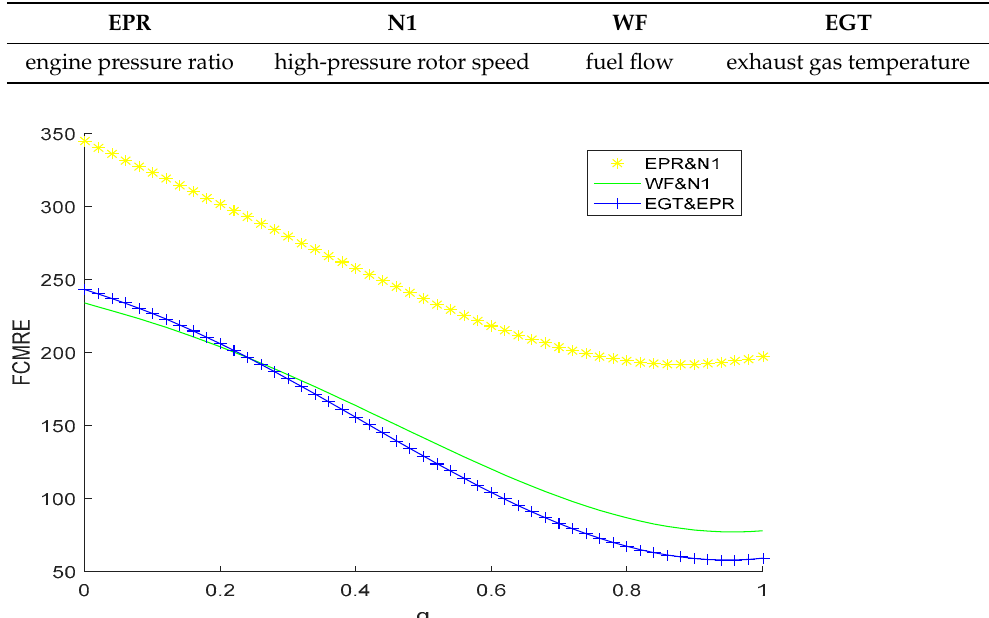
Table 1. Aeroengine data.